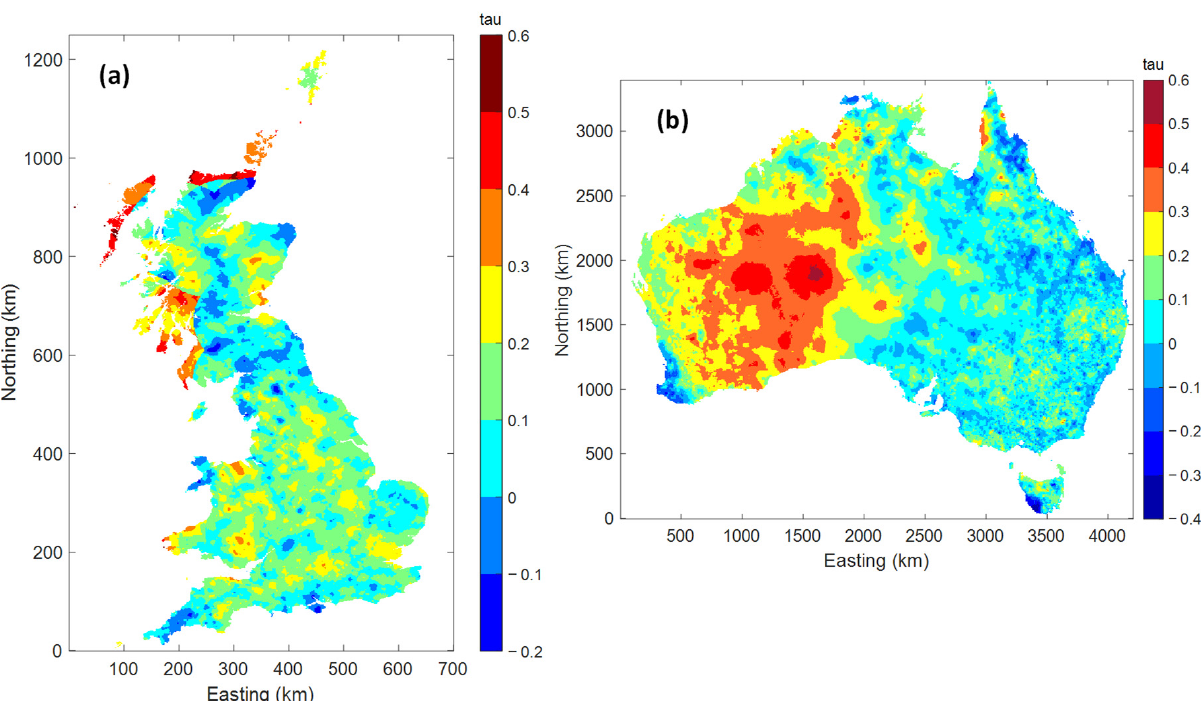
Figure 2. The trend of gridded AMDR over the last century in GB ( a ) and AU ( b ). The spatial features of the sampled ROIs (see Figure 3a,b) generated by the SRS-GDA toolbox [31] follow the same setups in [20], uniformly positioned across two countries marked by their geometric centroids, randomized with sizes (10–1050 km 2 for GB case and 125–9900 km 2 for AU case) and shapes (controlled by the spatial index sp varying from elongated to rounded with east–west and north–south orientations). For each ROI, the areal daily rainfall is calculated by taking the arithmetic average before the ROI-orientated AMDR is generated. This procedure is carried out using the HPC-Wales resources due to the huge amount of